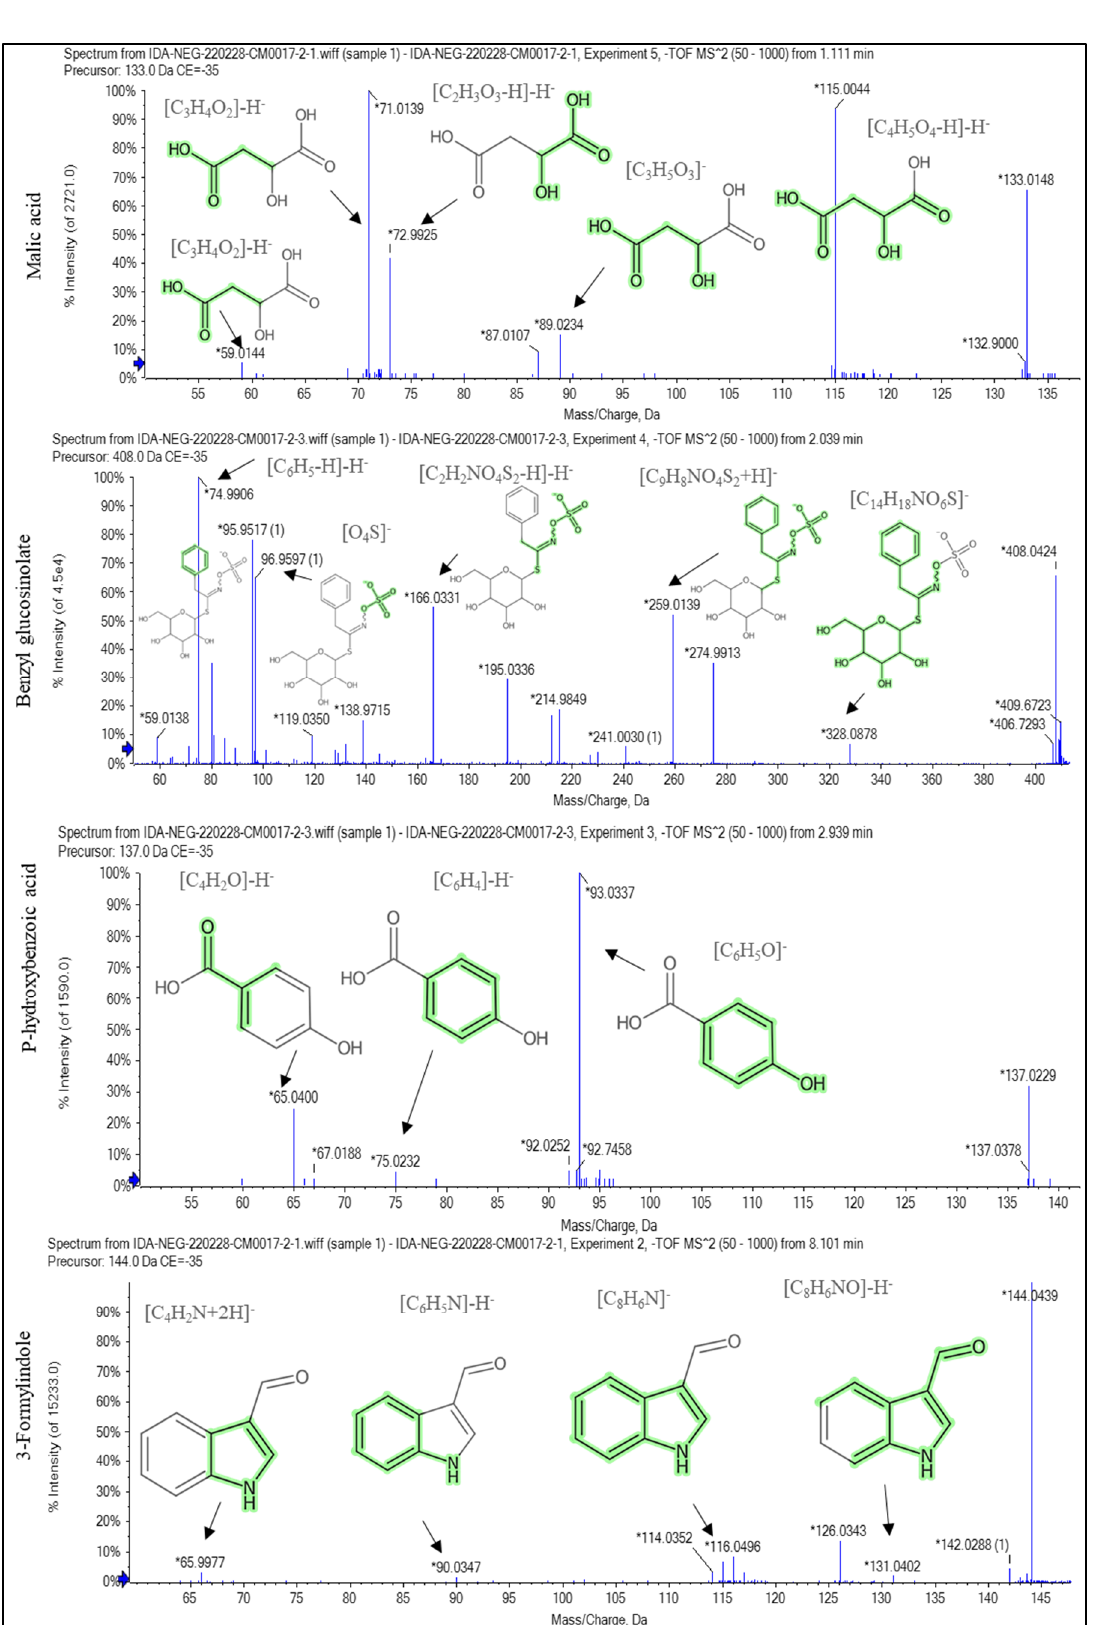
Figure 3. The fragmentation pattern of the main compounds recognized in the methanol extract of Salvadora persica stem bark: malic acid, benzyl glucosinolate, p-hydroxy benzoic acid, and 3- formylindole. * stands for m/z of [M+H] + , [M-H] − , and fragments of each compound.